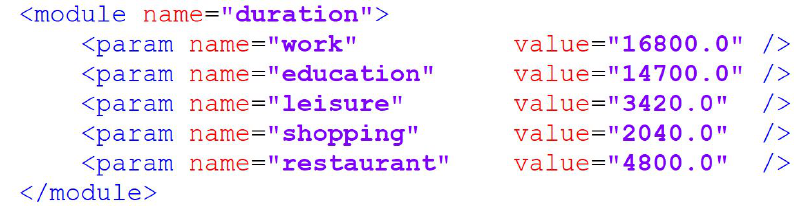
Figure 8. Population generator module—typical activity-durations (in seconds). Activity-duration distribution is built from the updated survey (ENTD) data for each activity. The observations are split based on the duration into bins with a specific range- length which depends on activity data, and the range length should be enough to avoid the bins with few observations. The different distributions are shown in Figure 9.